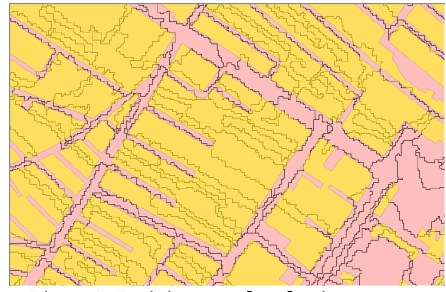
Figure 2. Training sample selection